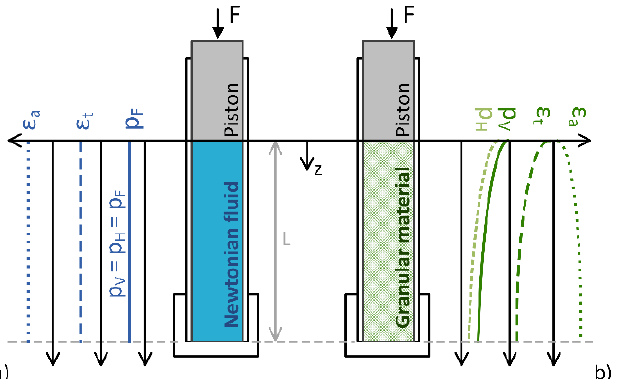
Figure 2. Graphical presentation of vertical p V ( z ) and horizontal p H ( z ) distribution of internal pressure, the distribution of axial ε a ( z ) and tangential ε t ( z ) strains at uniaxial compression in the case of ( a ) Newtonian fluid and ( b ) granular material.